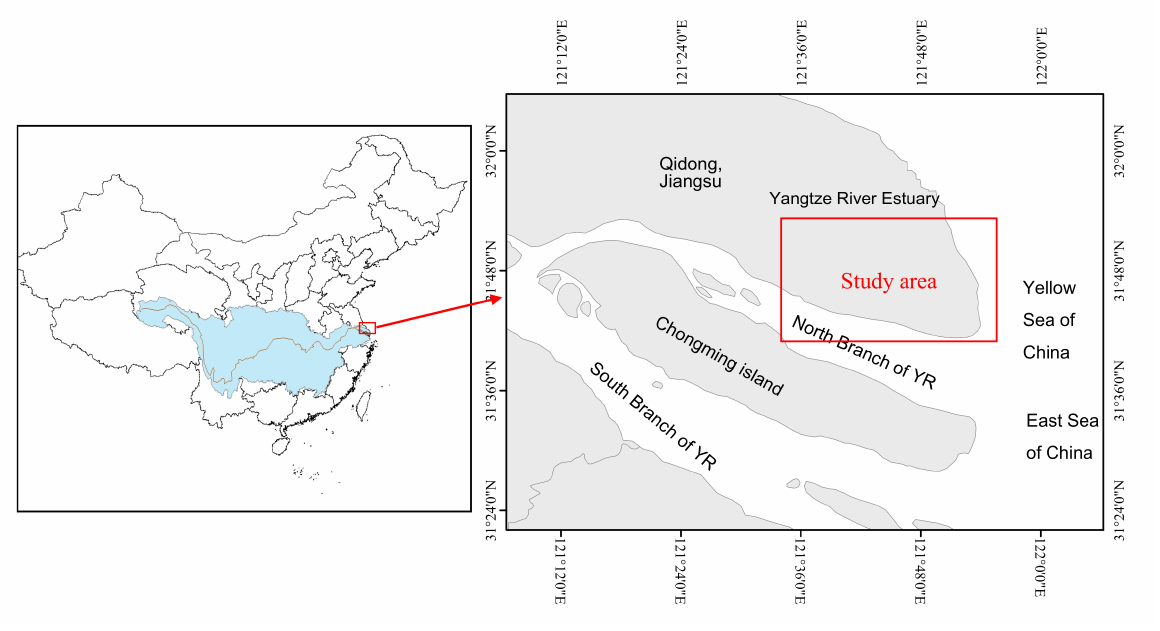
Figure 2. Locations of the study